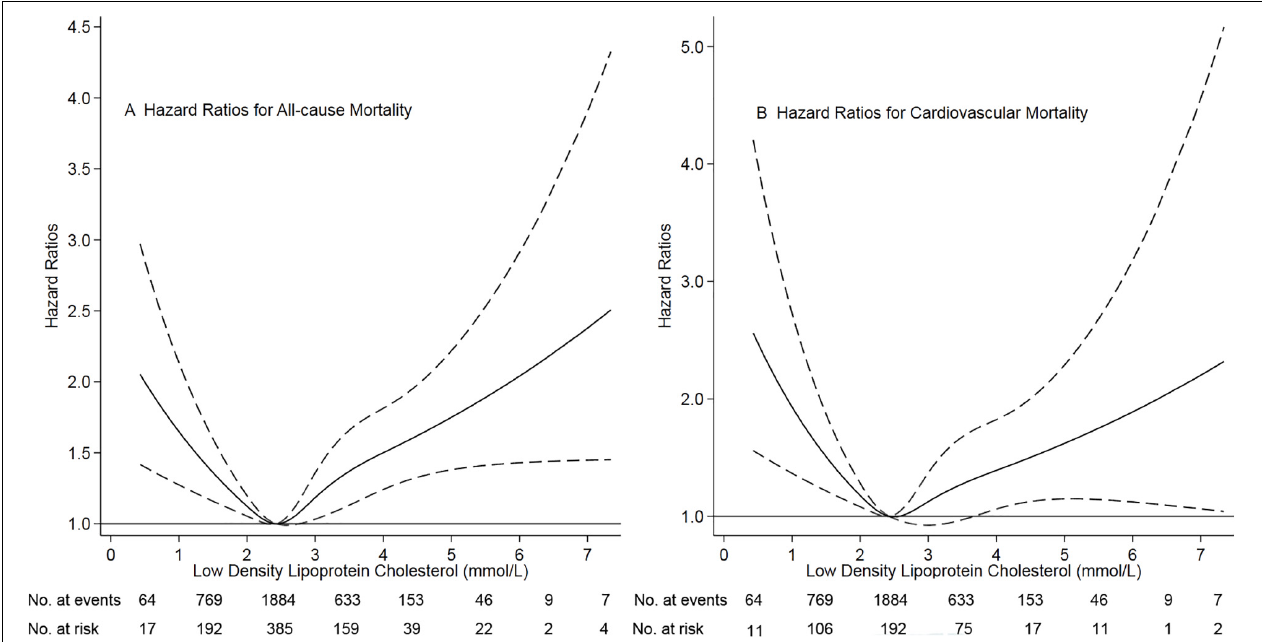
FIGURE 1 | Association of low-density lipoprotein cholesterol with risk of mortality. Panel (A) showed a restricted-cubic-spline plot of the association between LDL-C and all-cause mortality. Panel (B) showed a restricted cubic spline plot of the association between LDL-C and cardiovascular mortality. All plots were adjusted for age, sex, body mass index, current smoker, current alcohol use, systolic blood pressure, comorbidities, medication use, and laboratory variables. Dashed lines indicate 95% confidence intervals. The median LDL-C (2.43 mmol/L, [89 mg/dL]) was the reference standard, indicated by the grayline. LDL-C, low-density lipoprotein cholesterol.